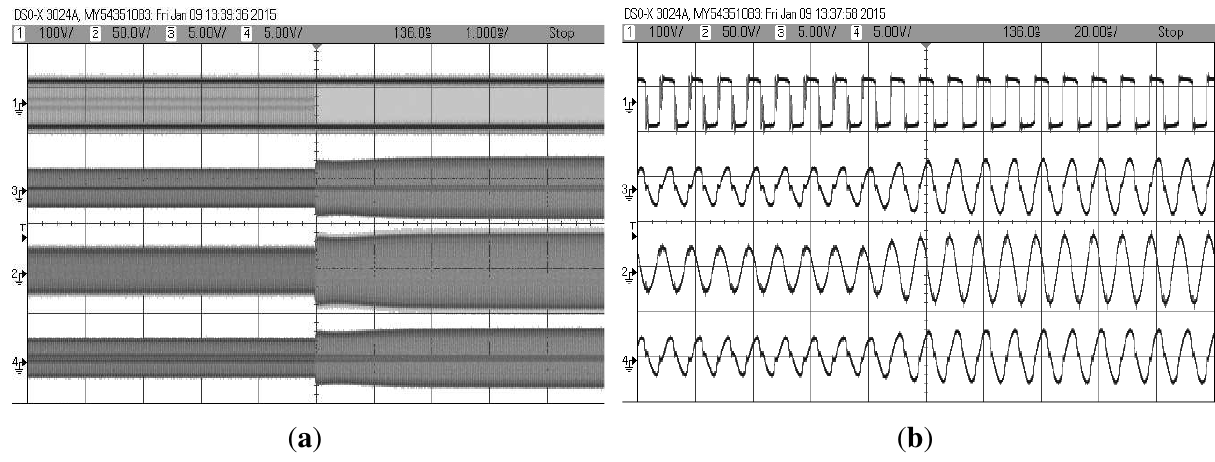
Figure 10. Experimental plots of the transient condition from half load to full load: ( a ) time scale, 1 ms/div; ( b ) expended view at time scale 20 µ s/div. Waveforms from top to bottom in each case: v (100 V/div) (on the secondary side), i t (on the secondary